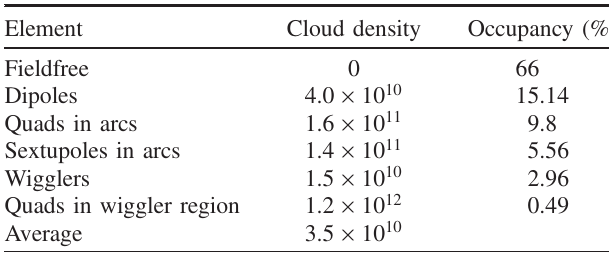
TABLE VII. Cloud density in the ring elements and their